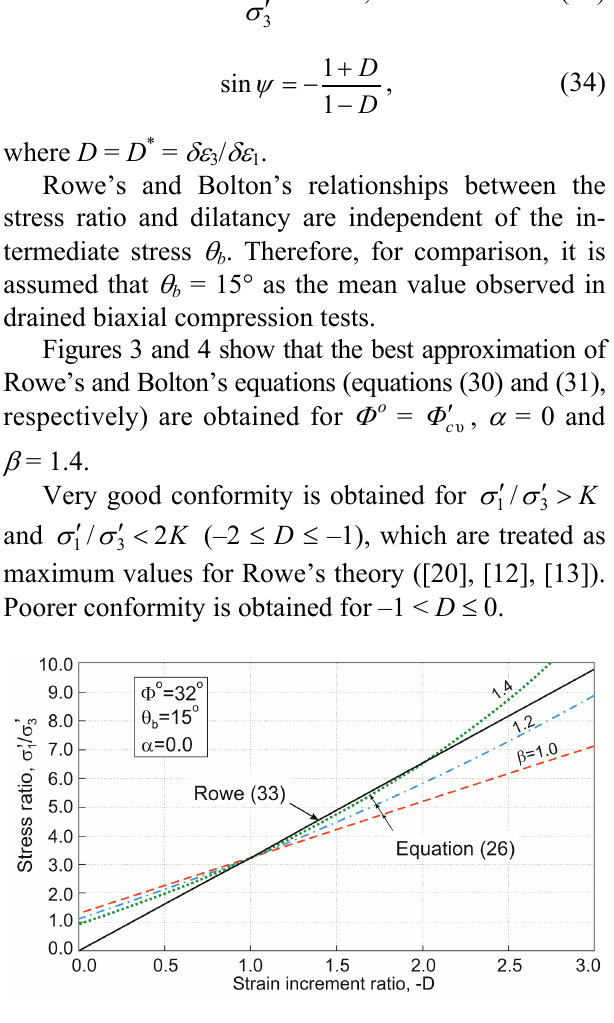
Fig. 3. Comparison of Rowe’s and frictional state theory relationships between the stress ratio and the strain increment ratio